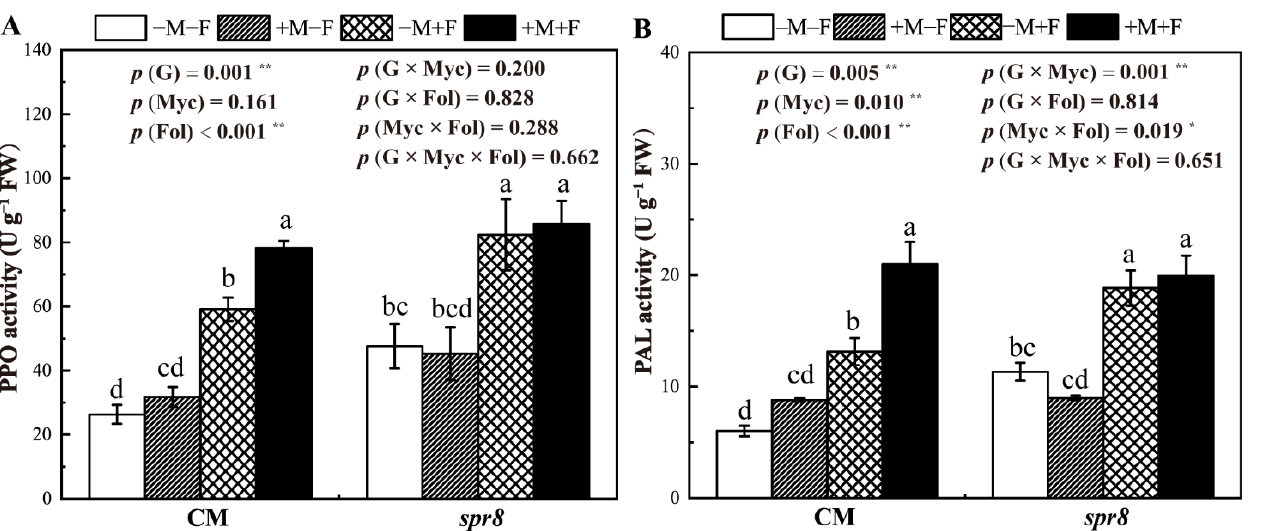
Figure 5. Effects of inoculation with Rhizophagus irregularis inoculation (Myc) and Fusarium ox- ysporum f. sp. Lycopersici (Fol) on the relative expression of AOC ( A ) and LOXD ( B ) of CM and spr8 plants (G). − M and +M represent non-inoculation and inoculation with Rhizophagus irregularis , re- spectively. − F and +F represent non-inoculation and inoculation with Fusarium oxysporum f. sp. Ly- copersici , respectively. Same lowercase letters above the columns indicate non-significant difference ( p < 0.05) between corresponding treatments. *— p < 0.05; **— p < 0.01.